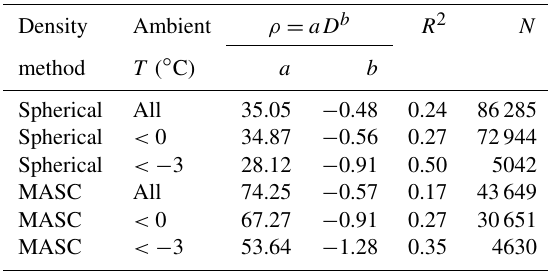
Figure 10. Density–diameter relationships for spherical (a) and MASC-adjusted (b) volume for all snowflakes. Contours shown are for the 25th, 50th, 75th, 90th, and 95th percentiles. Table 3. Density–diameter relationship comparison by ambient air temperature.